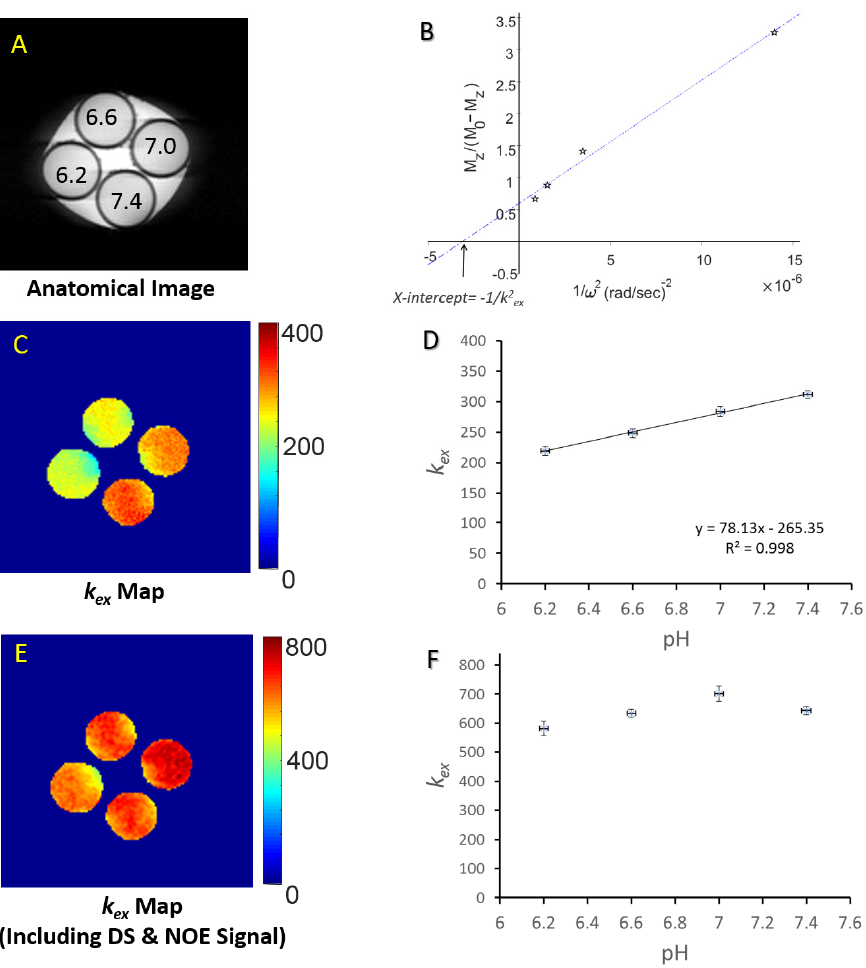
Figure 2. k ex MRI based on the DS-removed Omega plots implemented on phantom protein solutions containing 20% ( w / w ) bovine serum albumin (BSA) in phosphate-buffered saline (PBS) at room temperature with pH titrated to 6.2, 6.6, 7.0 and 7.4. ( A ) T 2 -weighted image of the phantoms ( B ) A typical Omega plot, M z /(M 0 − M z ) versus 1/ ω 2 ( ω = γ B 1 ), constructed from DS-removed Z-spectra for the pH 6.6 phantom. The linearity of the plot is clear. The x-intercept of the fit to the Omega-plot provides a direct readout of the exchange rate. ( C ) The constructed proton exchange rate maps. ( D ) The proton exchange rate values show that the exchange rate values increase linearly as pH increases. ( E , F ) The proton exchange rate values from the raw Z-spectra failed to distinguish different pH and did not show a linear dependency with pH values. (Reprinted with permission from Quant Imaging Med Surg. 2019;9(10):1686–96, Figure 5 (CC BY-NC-ND 4.0)).